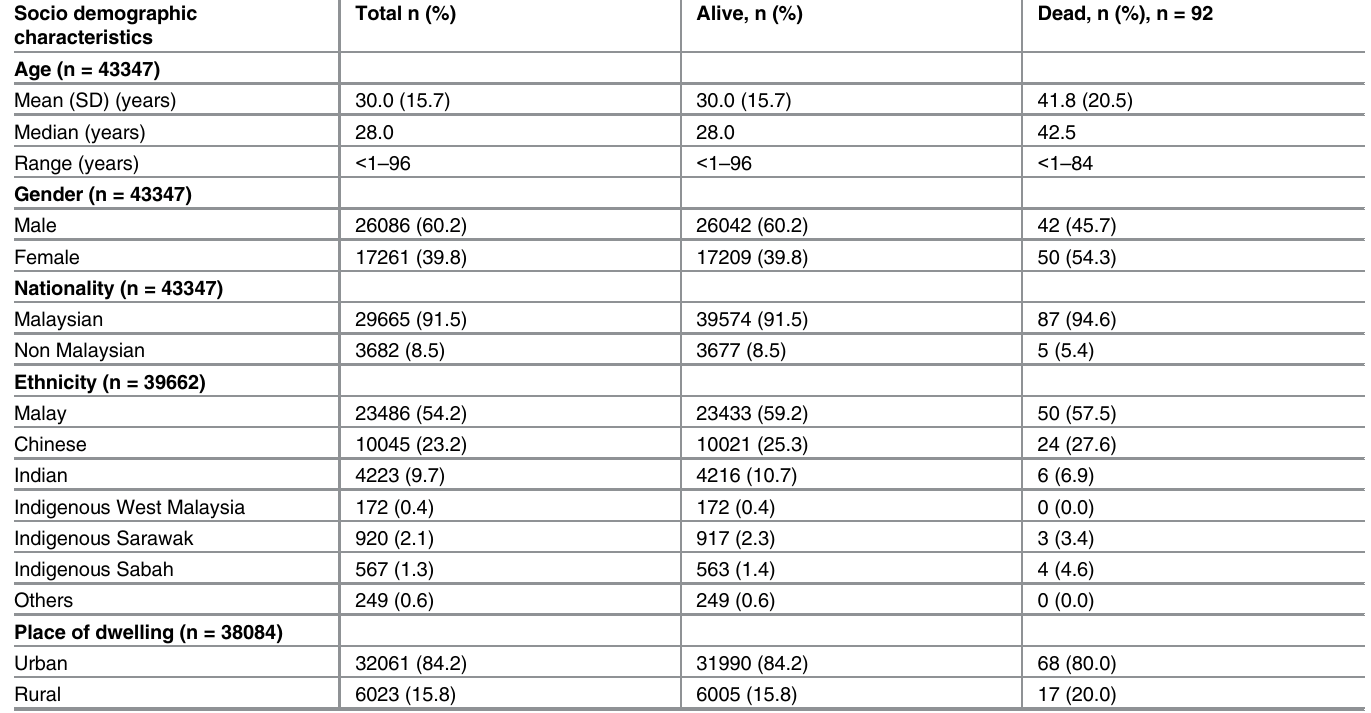
Table 1. Socio-demographic characteristics of patients with dengue in Malaysia in 2013 (n = 43347). Socio demographic